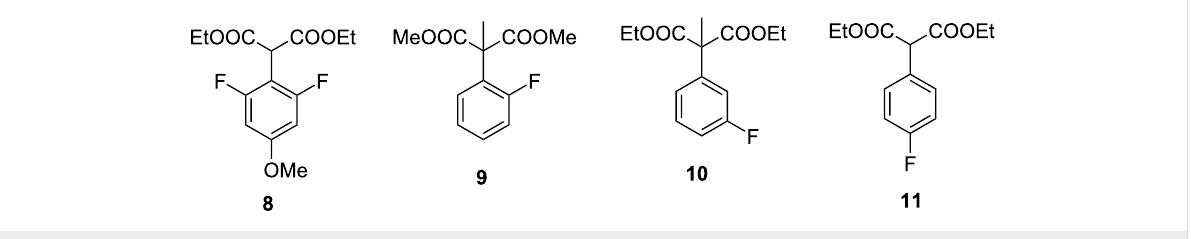
Figure 2: Esters of fluorine-substituted 2-phenylmalonic acids.